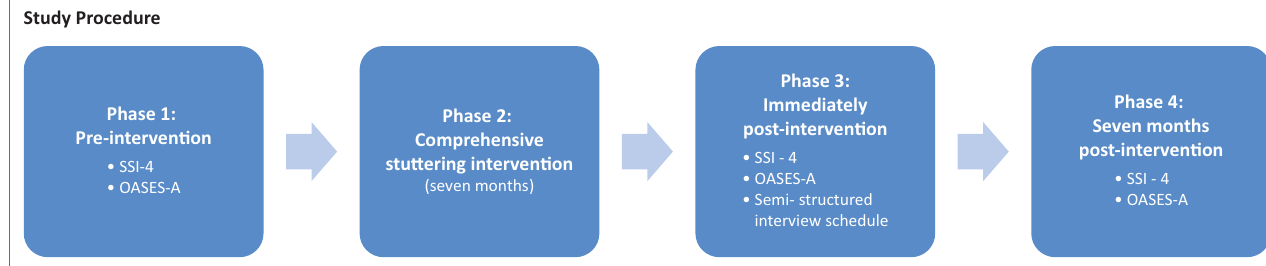
FIGURE 1: Four phases involved in data